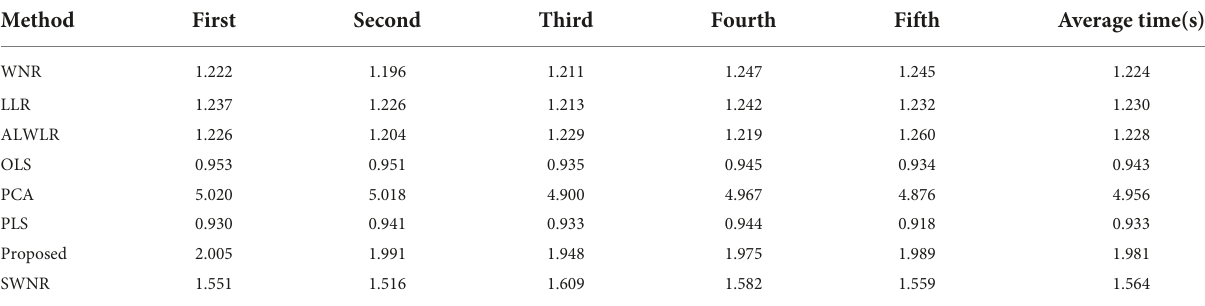
TABLE 6 Five running time of 10 times 10-fold cross-validation for eight methods and the average.